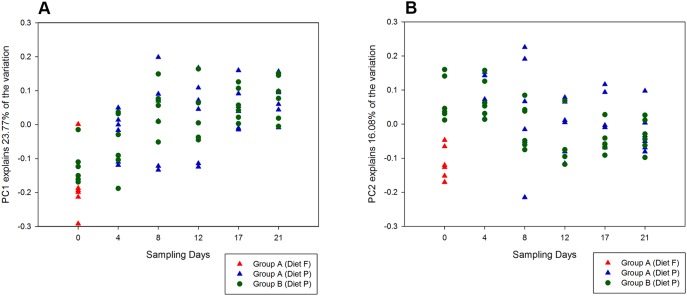
Principal coordinate analysis (PCoA) of bacterial communities detected in equine faeces over 3-weeks based on the Bray-Curtis dissimilarity metric.The plots illustrate the structure of the faecal bacterial communities in horses of Groups A and B on six sampling time-points over a period of three weeks. The plots show group-wise clustering of horses fed Diet F and Diet P on Day 0, and no clustering when horses were fed pasture (Diet P) from Days 4–21, with 24% variation explained on PC1 (A) and 16% variation explained on PC2 (B).